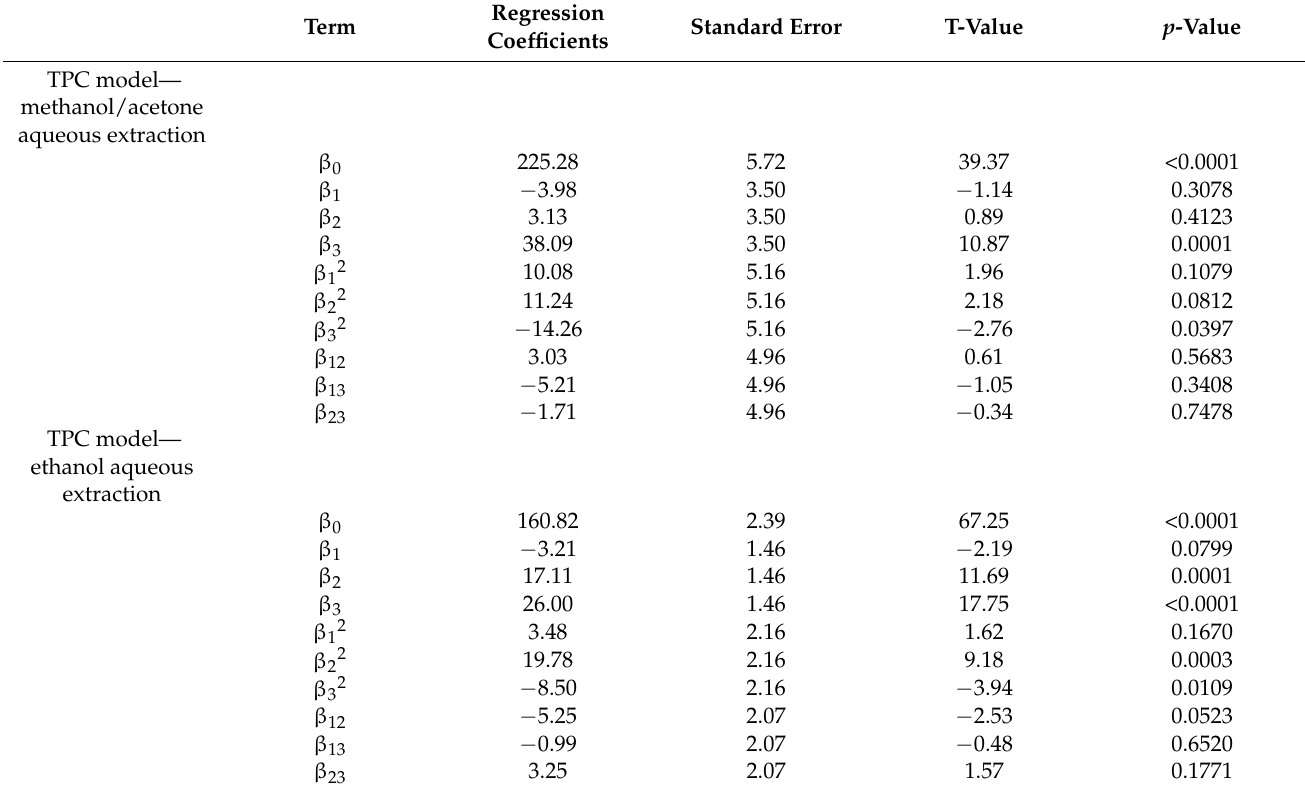
Table 2. Regression coefficients of the predicted second-order polynomial models for